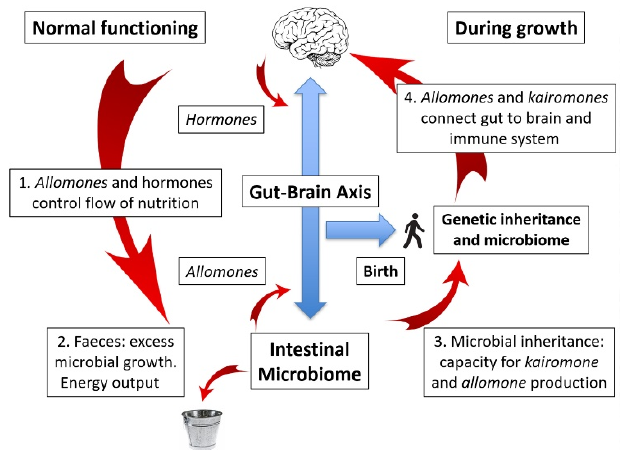
Figure 2. The gut–brain axis [50,51]. Left hand side: Normal functioning with a healthy microbiome already in place. Box 1: Illustrates the operation of the gut–brain axis following input from both brain (hormones) and growing microbiome (allomones). The result is the partition of nutrition to satisfy the needs of both body and growing microbes. Box 2: As allomones are produced during active microbial growth excess is ejected at intervals, along with waste products. In contrast, a poorly growing microbiome will produce a correspondingly lower volume of waste products. Allomone production will be lower and more nutrition will be retained within the body (Figure 1). Right hand side: Processes occurring during the growth phase with a functioning microbiome. Box 3: As the child embodies the genetic inheritance of its parents, so the microbiome of the mother is transferred to the child, with its potential for future development. Box 4: The kairomone system operates throughout the growth process, directing the immune system to tolerate its environment. A poorly growing microbiome may result in problems with the immune system. Allomones and hormones act in concert so as to strengthen the gut–brain axis. A failure at this stage allows the potential for poor mental